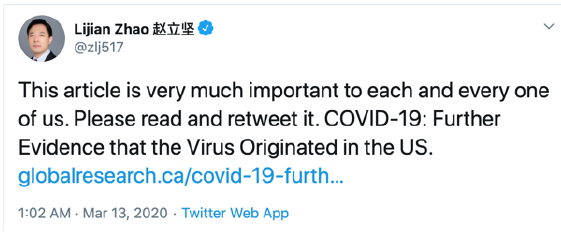
Figure 5. Screenshot of @zlj517’s tweet. Source: L. Zhao (2020).